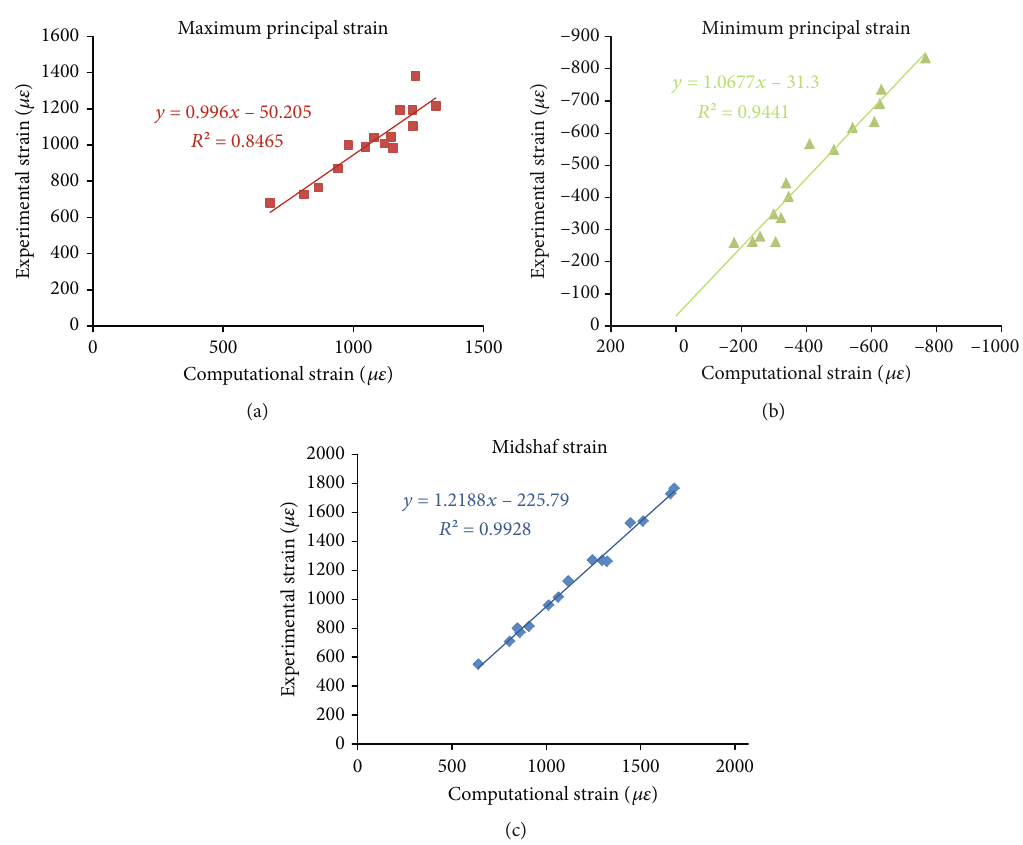
Figure 10: Linear regressions of the computational and experimental strains: (a) maximum principal strain; (b) minimum principal strain; (c) midshaft strain. Table 3: Comparison of the strains obtained by strain gauge measurement and FEA ( mean ± SD ).